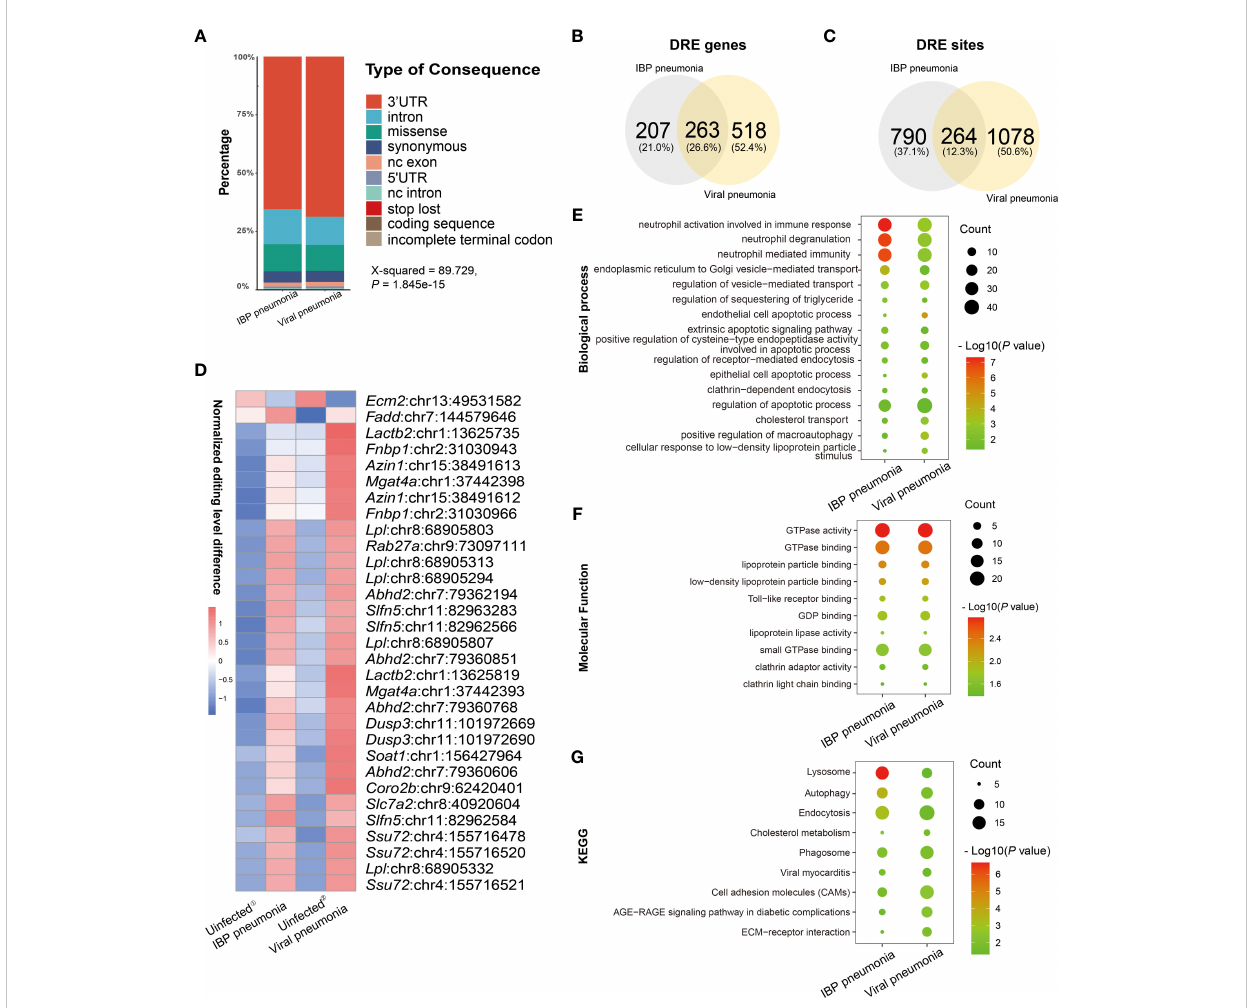
FIGURE 5 Comparison of RNA editing pro fi les between IBP and viral pneumonia. (A) The functional categories of A-to-I RNA editing sites in IBP and viral pneumonia. Venn plots comparing (B) differential RNA editing (DRE) genes and (C) sites between IBP and viral pneumonia. (D) Top 30 DRE sites shared by IBP and viral pneumonia. ① : controls for IBP; ② : controls for viruses. Shared (E) biological processes, (F) molecular functions, and (G) KKEGG pathways enriched by DRE genes between IBP and viral